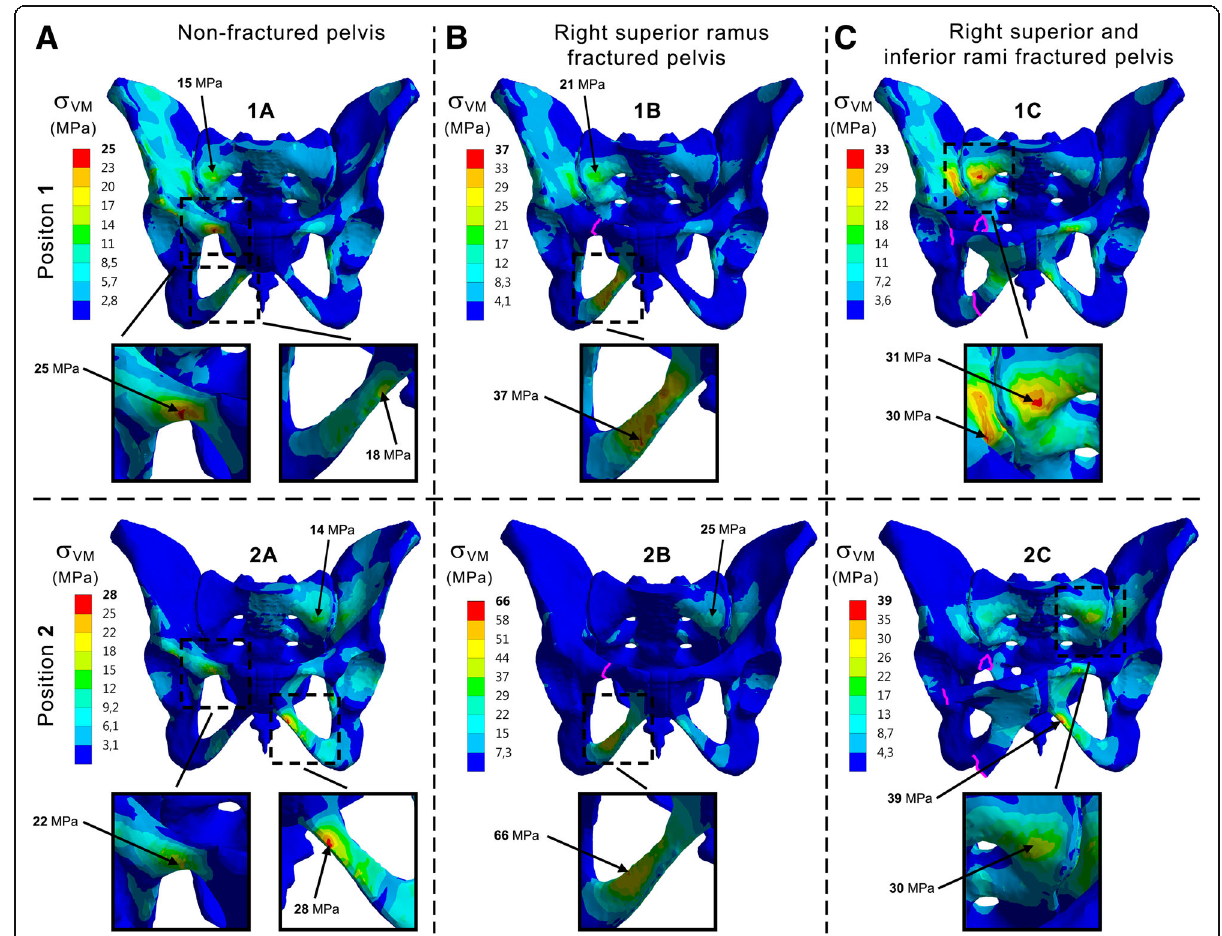
Fig. 3 Frontal views of Von Mises stresses applied to the pelvis. 1 : Position 1. 2 : Position 2. A : Non-fractured pelvis. B : Right superior ramus fractured pelvis. C : Right superior and inferior rami fractured